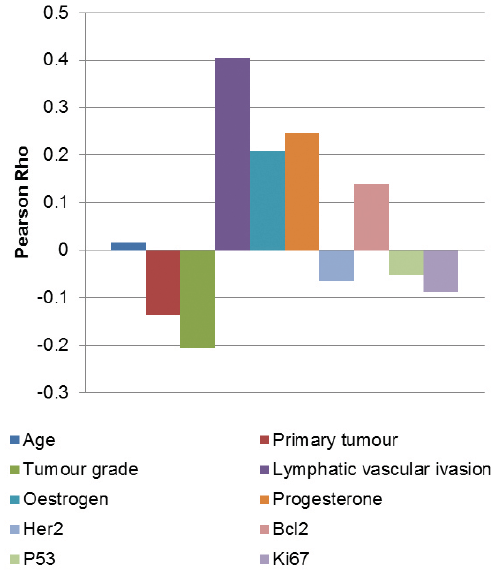
FIGURE 4. Axillary lymph node metastasis showed strong correlation only with existence of lymphatic vascular invasion